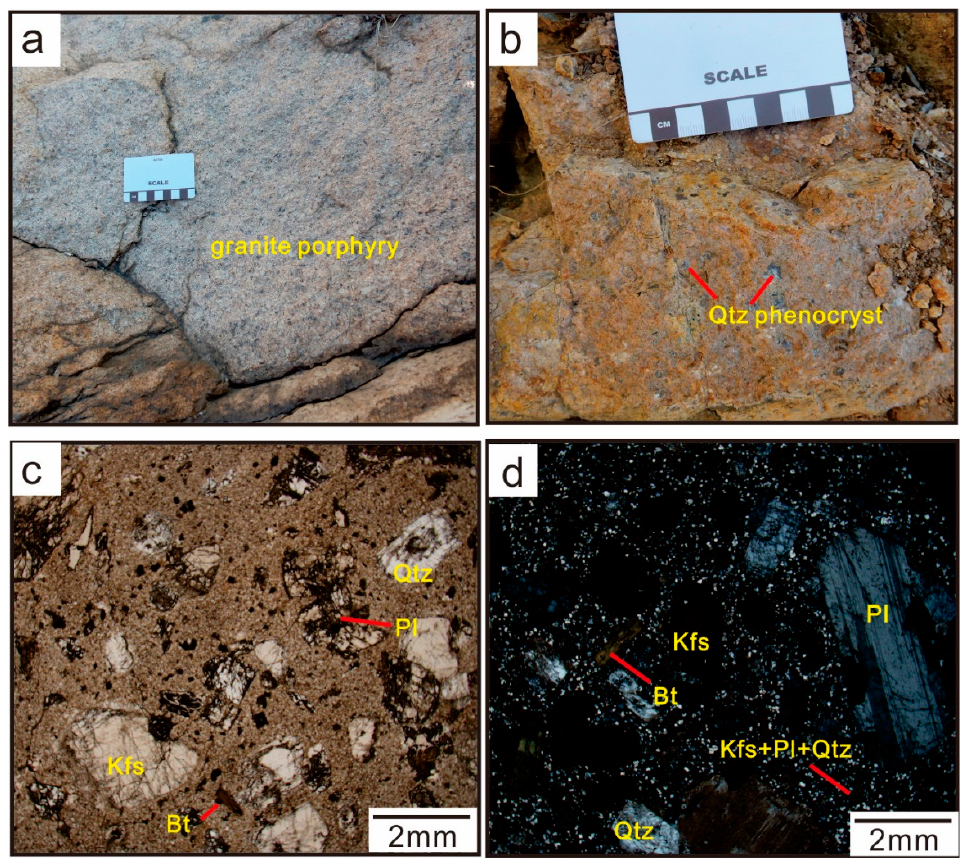
Figure 2. Photographs of representative samples from the Banzhusi granite porphyry. ( a , b ) Macroscopic Banzhusi granite porphyry with quartz, plagioclase and K-feldspar phenocrysts. ( c ) Photomicrographs of the granite porphyry, showing a mineral assemblage of K-feldspar + plagioclase + quartz + biotite, plane-polarized light. ( d ) Photomicrographs of the granite porphyry, showing a fine-grained granular matrix of K-feldspar + plagioclase + quartz, with K-feldspar + plagioclase + quartz phenocrysts; cross-polarized light. Abbreviations: Amp, amphibole; Bt, biotite; Kfs, K-feldspar; Pl, plagioclase; Qtz, quartz.